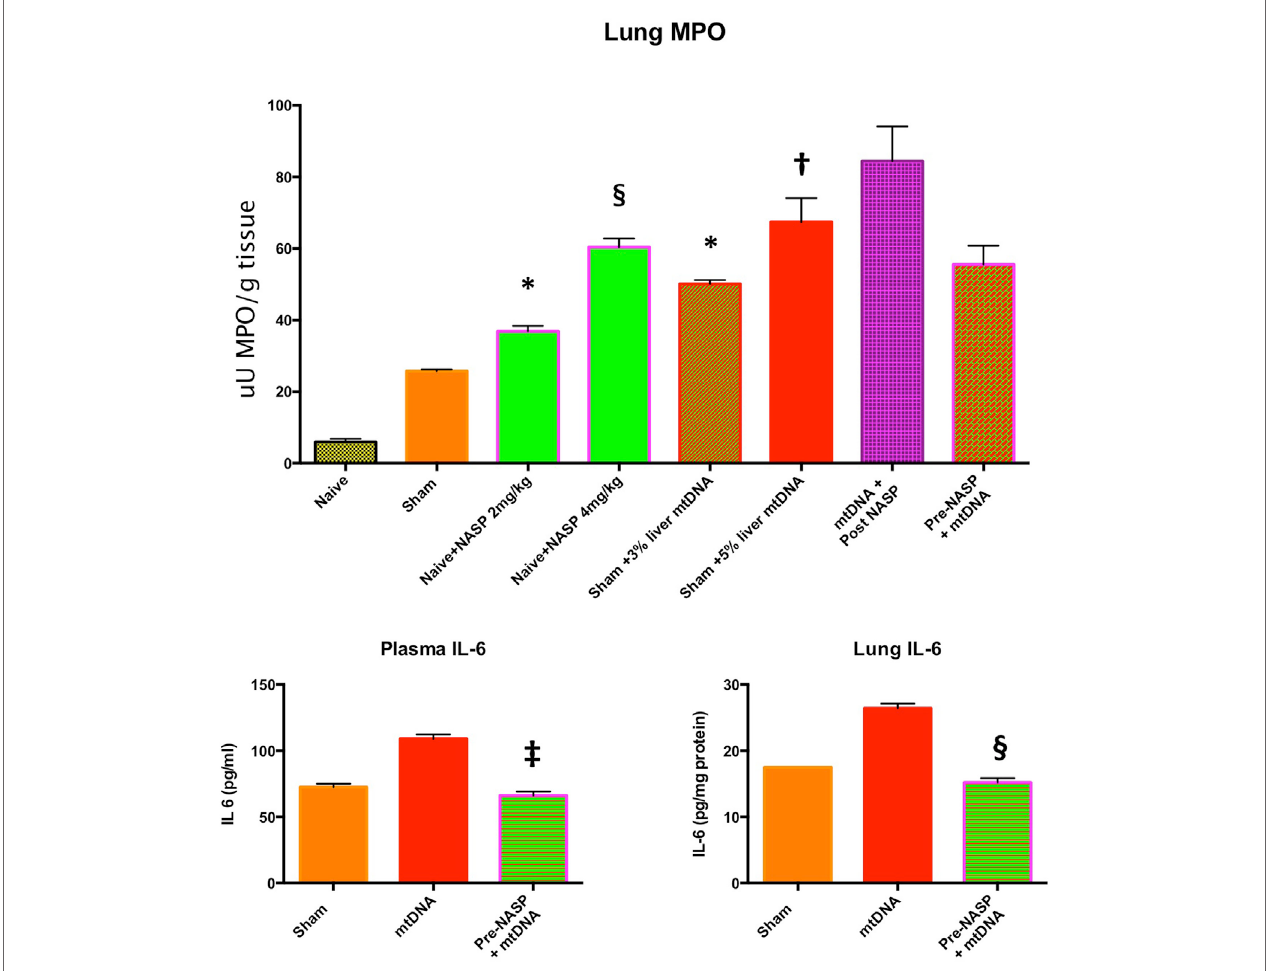
FigUre 10 | Lung myeloperoxidase (MPO), lung and plasma IL-6. Lung MPO (Top): Injection of nucleic acid scavenging polymer (NASP) (hexadimethrine bromide) 2 and 4 mg/kg into naïve rats. Lungs sampled at 6 h. There were significant increases in MPO with both doses compared to naïve animals indicating lung toxicity at the higher dose especially, * denotes p < 0.05, § denotes p < 0.0001. Pure mitochondrial DNA (mtDNA) extracted from 3 and 5% rat liver by total weight was injected into sham animals with dose-dependent increases in lung MPO compared to sham animals, * denotes p < 0.05, † denotes p < 0.01. Then, pure mtDNA extracted from 5% liver was injected into shams followed by NASP 2 mg/kg 30 min later; there was no significant change in MPO found. Finally, shams were injected with NASP 2 mg/kg followed by 5% liver pure mtDNA injection 15 min later. No significant alteration in lung MPO was found. t -tests throughout. n = 3–5 animals per group. Plasma and lung IL-6 (Bottom) were both measured by ELISA: Injection of pure mtDNA extracted from 5% liver resulted in a significant rise in both plasma and lung IL-6 concentrations, p < 0.01. Pretreatment of sham animals with NASP 2 mg/kg followed by injection of pure mtDNA extracted from 5% liver 15 min later resulted in the attenuation of both values to sham levels, ‡ denotes p < 0.001, § denotes p < 0.0001 vs pure mtDNA, t -tests. n = 3–5 animals per group. Overall, MPO appears to be a very sensitive marker of lung injury. Pretreatment with NASP attenuated other inflammatory marker increases with pure mtDNA injections. Mean values with SEM